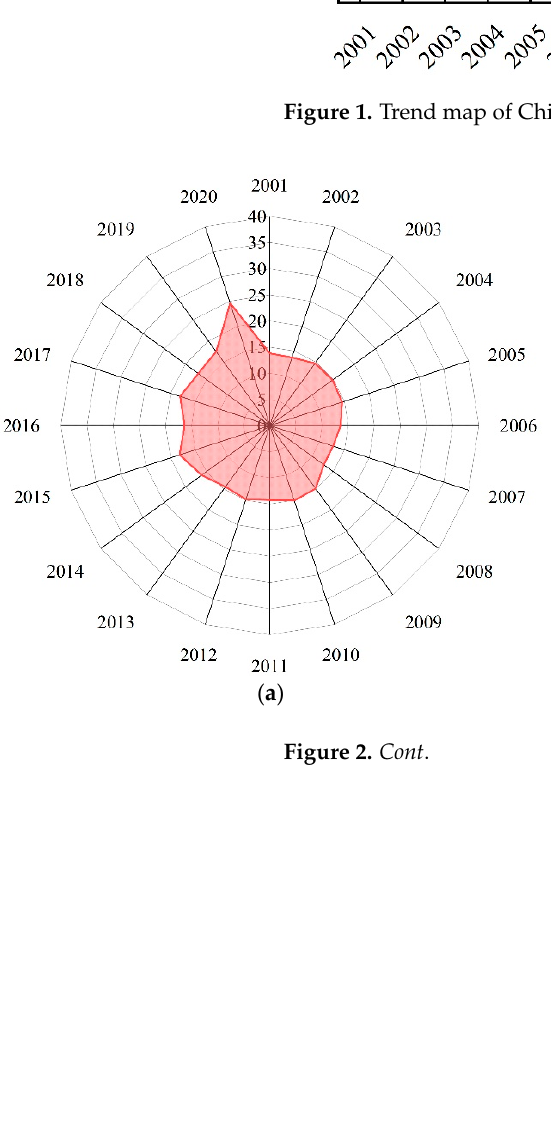
Figure 1. Trend map of China’s food security grades from 2001 to 2020.